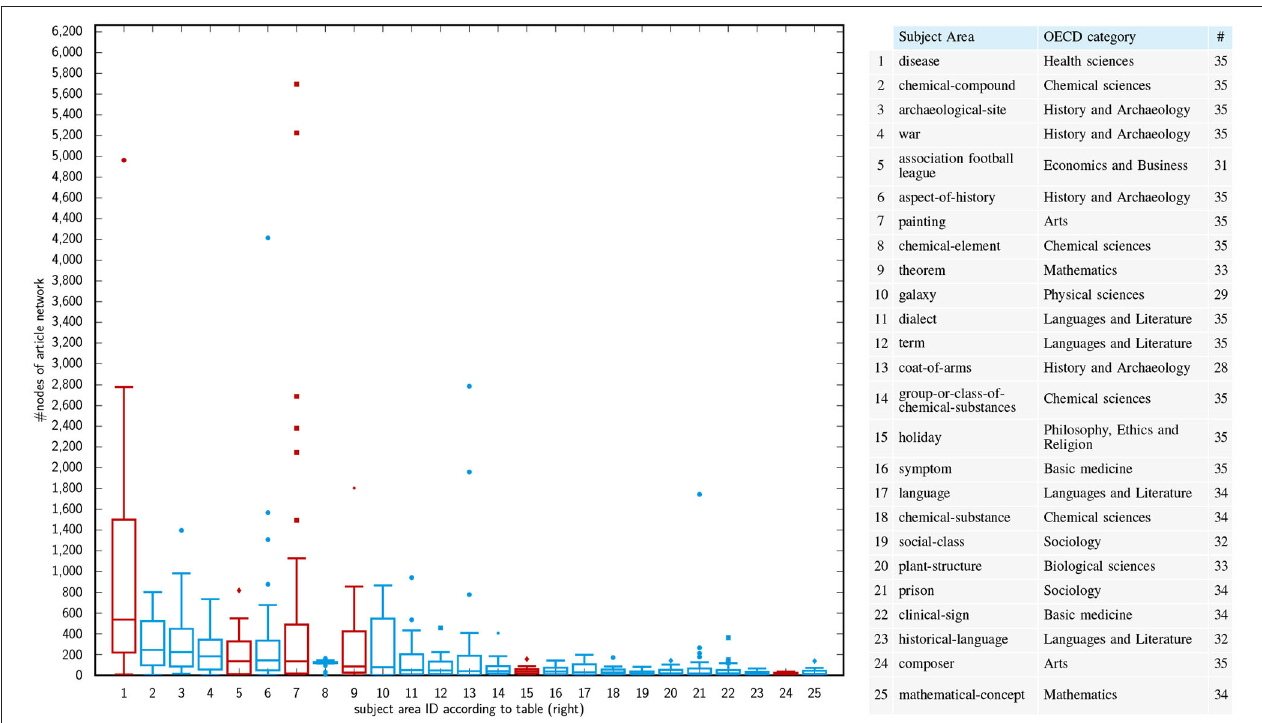
FIGURE 8 | Boxplots of node distributions of article graphs extracted for the corresponding subject areas and language subsets as shown in the legend on the right. Red plots signal 6 additionally selected